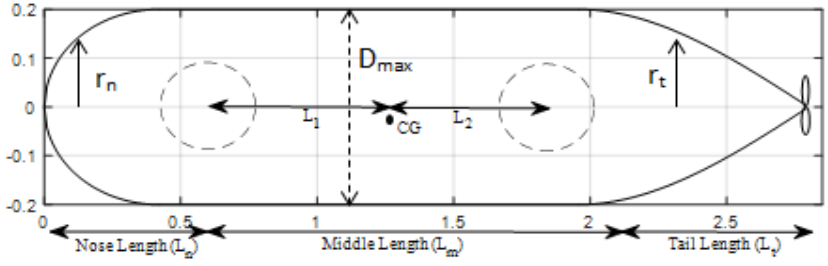
Figure 10. Modular form of AUV integrated with VBS for CSM. Table 4. ( a ) Technical Specifications of VBS ( b ) Input and Output Design Parameters of CSM for the Design of VBS.